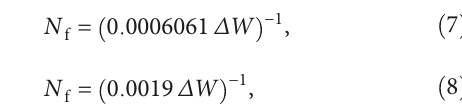
Figure 8: Temperature pro fi le of the lunar lander exposed to the lunar surface features: fl at surface, valley, and